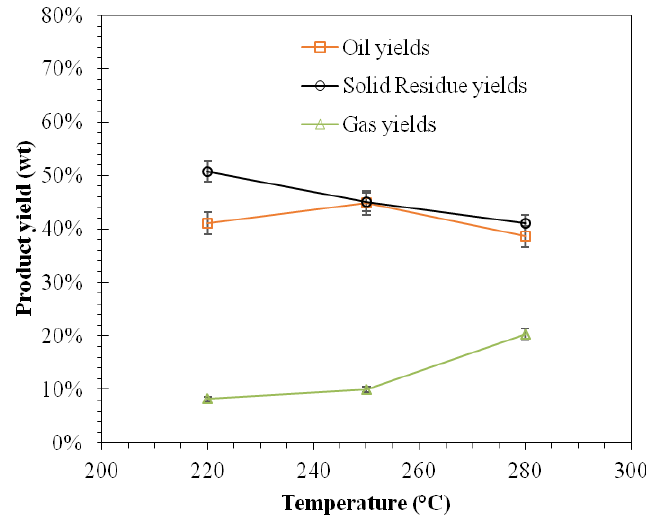
Figure 4. Effects of reaction temperature on product yields (H 2 O-EtOH medium, 30 min, H 2 SO 4 catalyst).